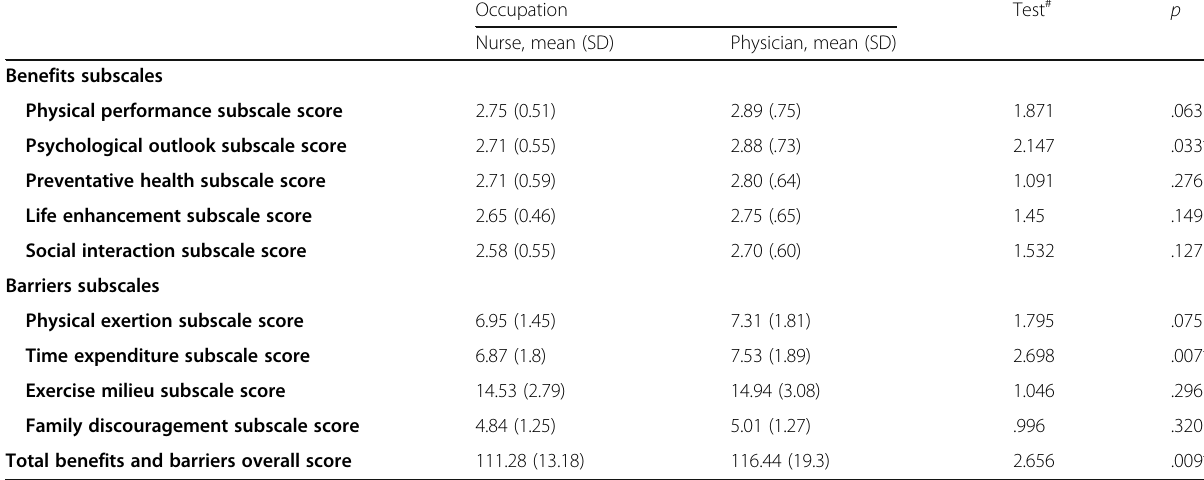
Table 6 Comparison between nurses and physicians as regard benefits and barriers subscales